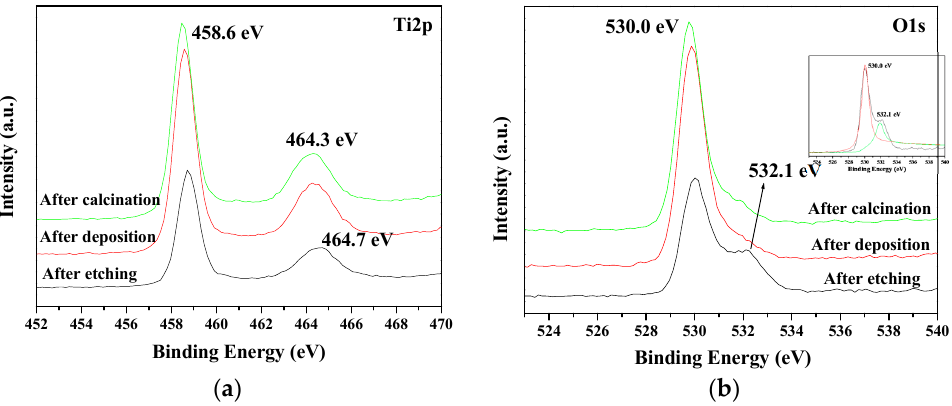
Figure 4. X-Ray photoelectron spectroscopy spectra of TiO 2 nanowire arrays under different preparation stages. ( a ) Ti2p: 2p orbit of titanium; ( b ) O1s: 1s orbit of oxygen.